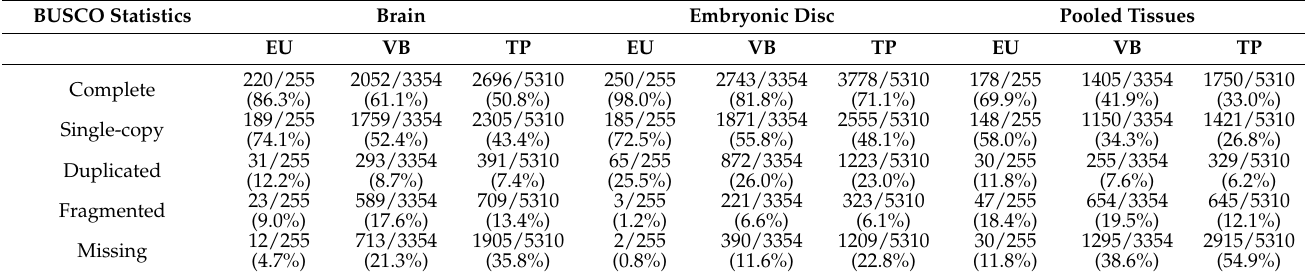
Table 2. Benchmarking Universal Single-Copy Orthologs (BUSCO) results based on the eukaryotic (EU, eukaryota_odb10; 255 BUSCOs), vertebrates (VB, vertebrata_odb10; 3354 BUSCOs), and tetrapod databases (TP, tetrapoda_odb10, 5310 BUSCOs) searched. BUSCO searches for completed, single-copy, duplicated, fragmented, and missing orthologs within given genomes.